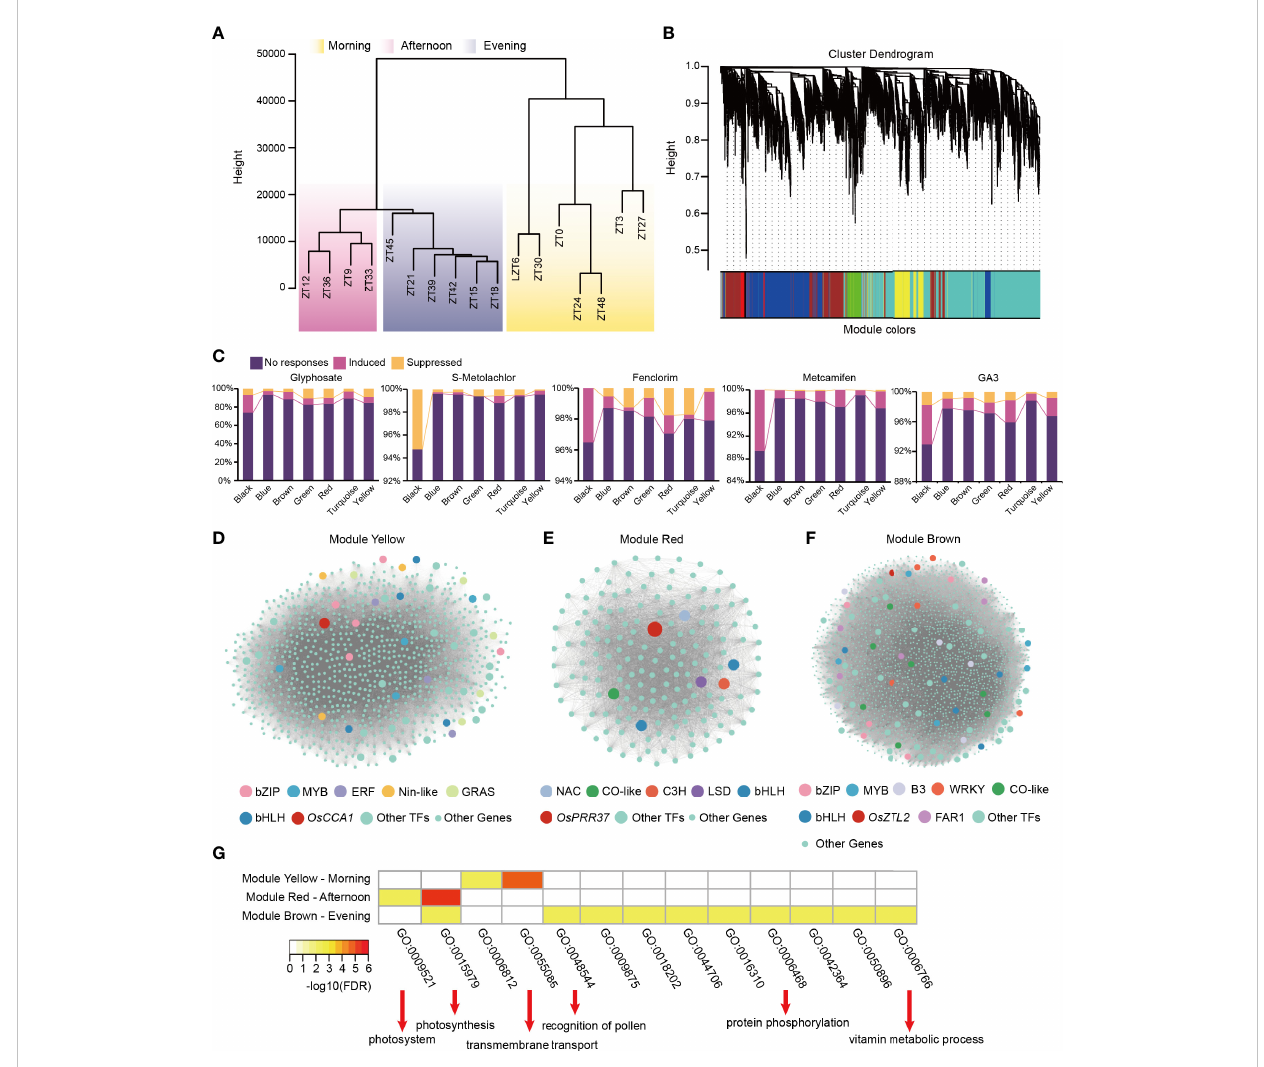
FIGURE 4 Co-expression analyses of 24h periods circadian rhythm genes. (A) Hierarchical clustering dendrogram showing samples grouping into morning, afternoon and evening clusters. (B) Dendrogram showing transcript co-expression modules (clusters) identi fi ed by WGCNA across different times. The major tree branches constitute 7 modules labeled with different colors. (C) Proportion of genes in each module in response to herbicide application. (D – F) Co-expression network of module yellow, module red and module brown, respectively. The types of each transcription factor family are shown in the fi gure legend. (G) Heatmap of GO enrichment analysis of genes in module yellow (upper), red (medium) and brown (bottom),